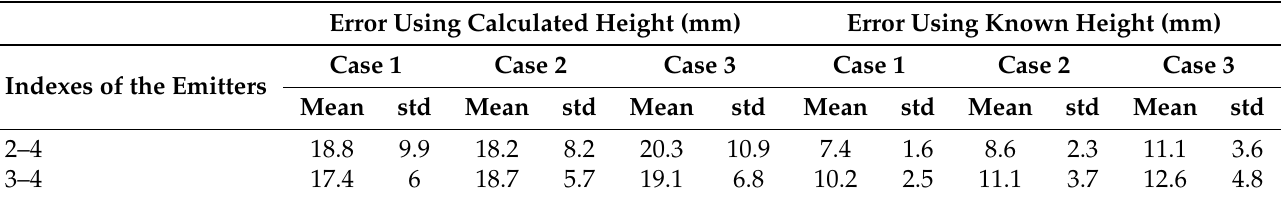
Table 6. Std error of the 44 receiver positions using calculated and known height in the three test cases. Error Using Calculated Height (mm) Error Using Known Height